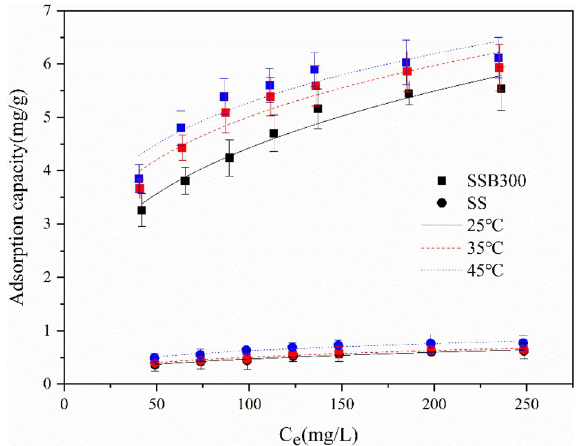
Figure 7. The adsorption thermodynamic isotherm of ammonium (Freundlich).